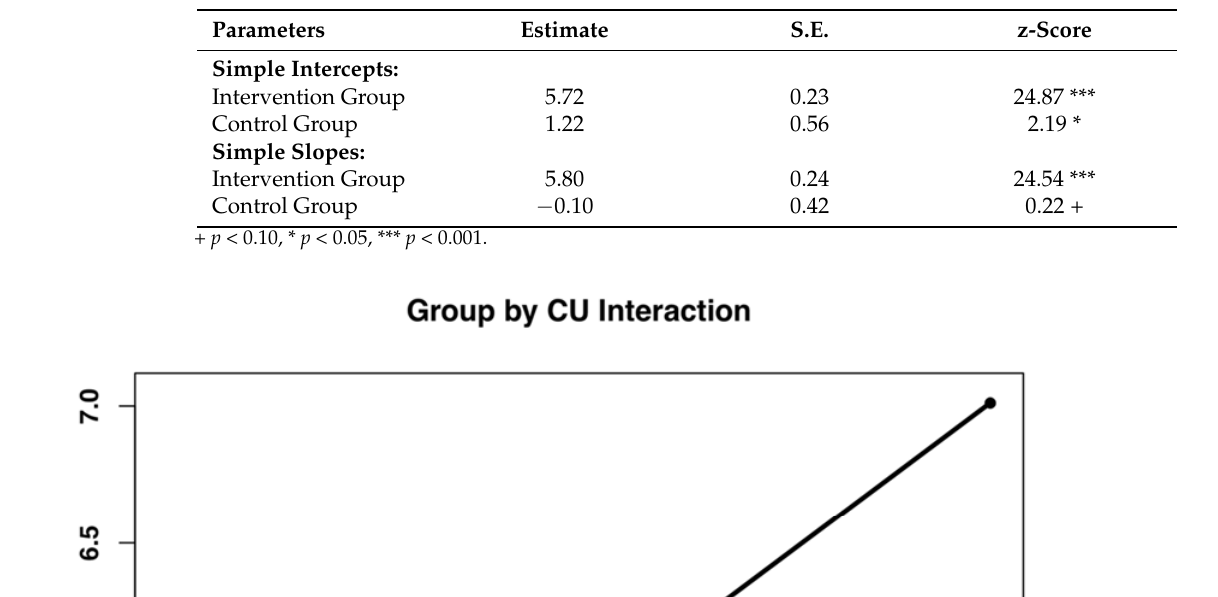
Table 5. Simple Intercepts and Slopes for Interactive Model Predicting Intervention Group’s FACES Fear Accuracy.